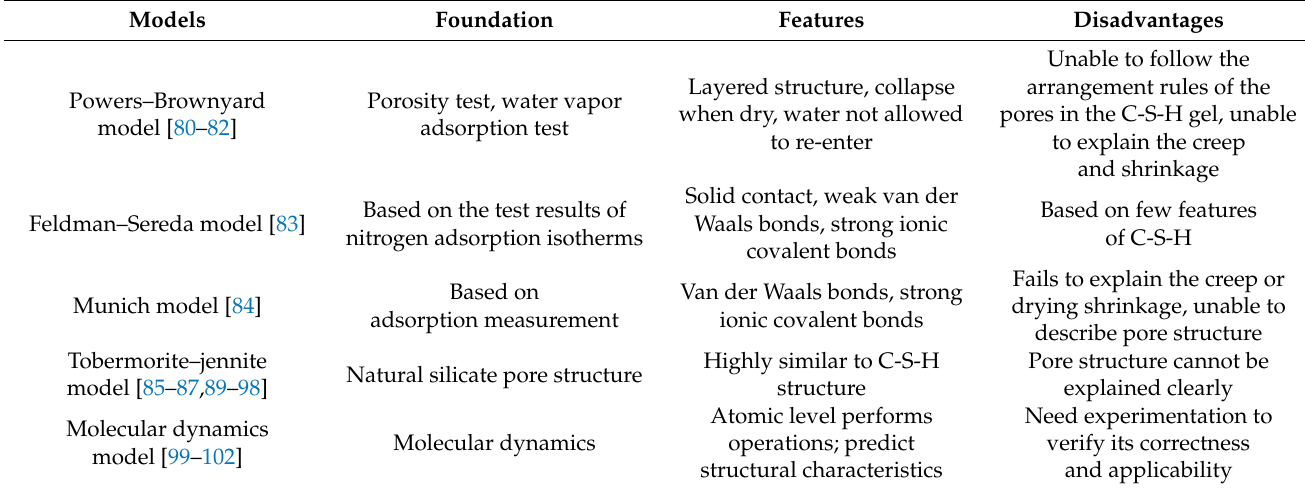
Figure 7. One of the C-S-H structures simulated by molecular dynamics [14]. Table 2. Several C-S-H models.